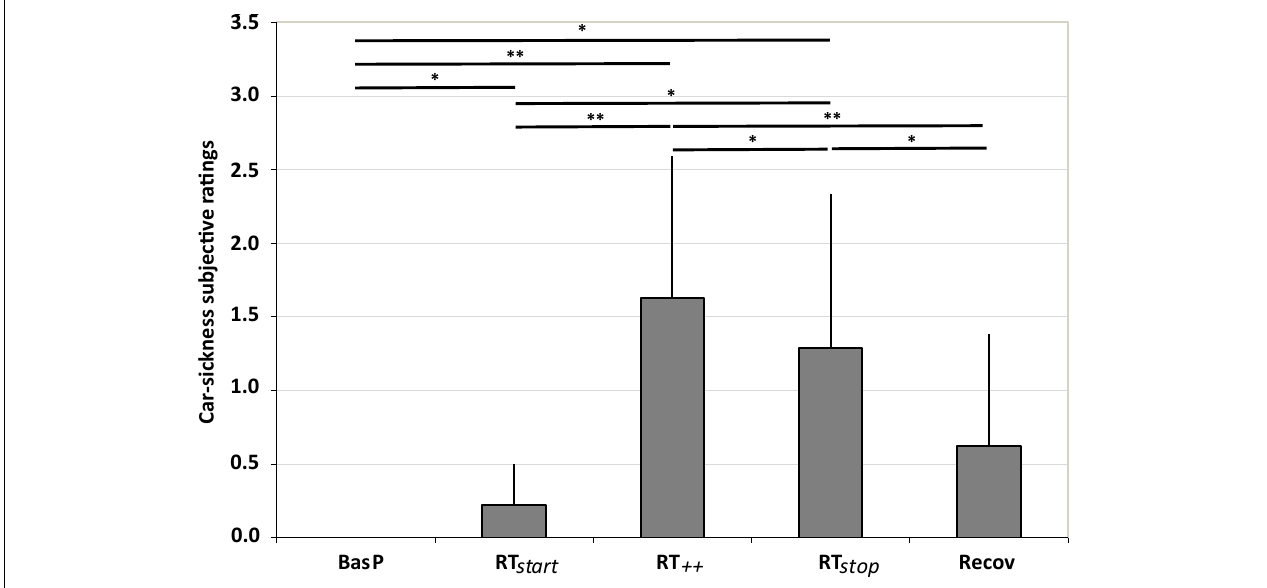
FIGURE 5 | Car-sickness subjective ratings observed for each test period (BasP, RT start , RT ++ , RT stop and Recov) (mean ± SEM; n = 9; * p < 0.05 and ** p < 0.01 at risk α = 0.05).